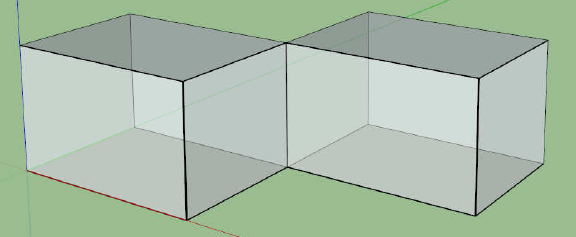
Figure 18: Topological error caused by an edge with 4 adjacent polygons